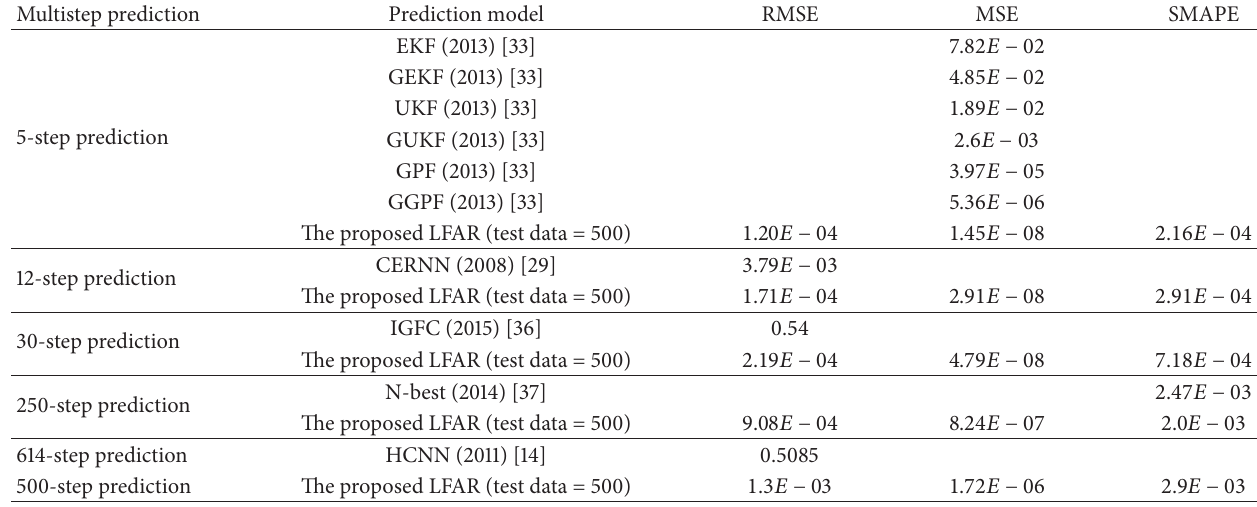
, 𝑑 ,ℎ ,𝑞 , 𝑚 ,𝜏 ) = (3,3,0.1792, 54, 6, 6) ). opt opt opt opt opt opt